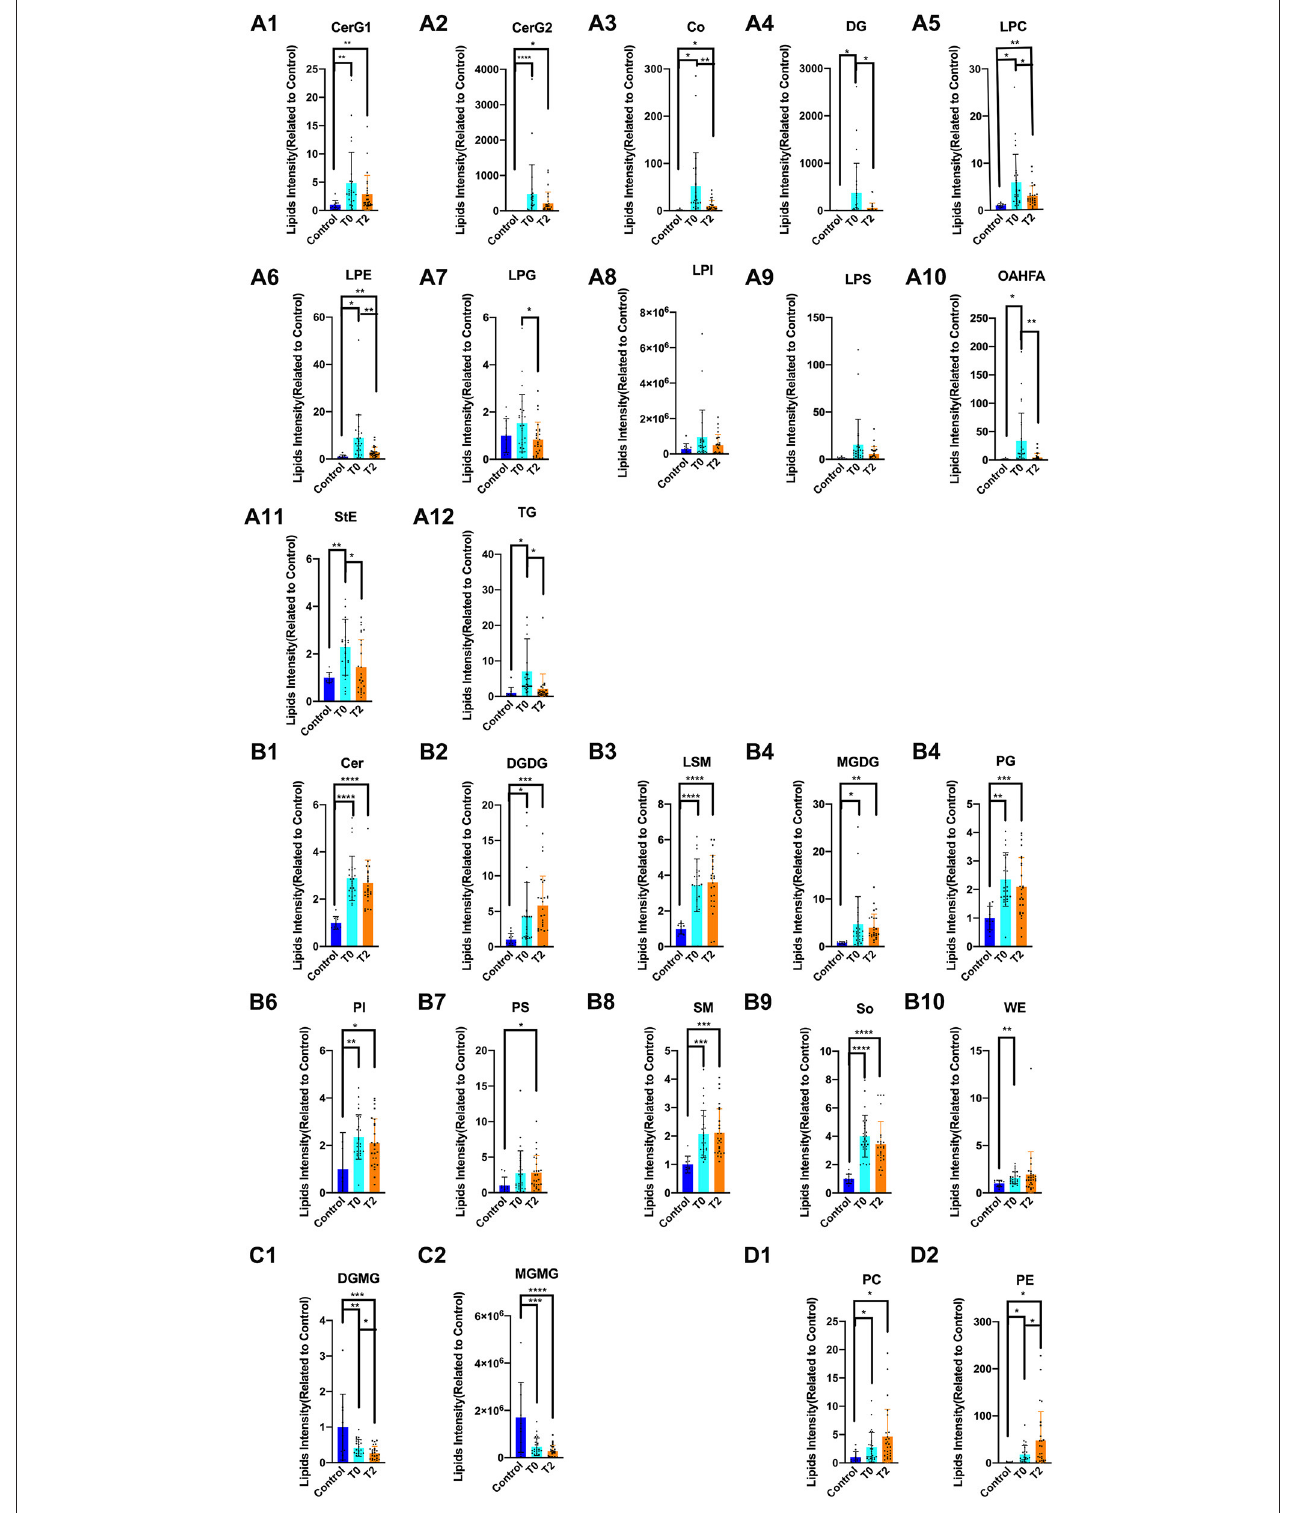
FIGURE 3 | The alternation of lipid compound involved in IPL treatment. * p < 0.05, ** p < 0.01, *** p < 0.001, **** p < 0.0001. Control ( n = 10), T0 ( n = 26), T2 ( n = 26). (A1–A12) The increased lipids in T0 of CerG1, CerG2, Co, DG, LPC, LPE, LPG, LPI, LPS, OAHFA, StE, and TG were decreased after treatment of IPL(T2). (B1–B10) There was no significant difference in Cer, DGDG, LSM, MGDG, PG, PI, PS, and SM, So, WE that increased in T0 and T2. (C1–C2) The decreased lipids in T0 of DGMG and MGMG could be reversed by treatment of IPL(T2). (D1–D2) Even more, the PC and PE were higher than T0 in